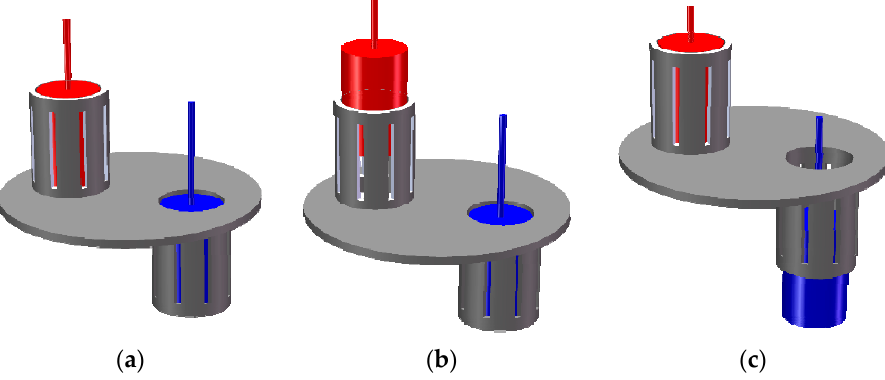
Figure 3. The response modes of the self-adaptive auxiliary control (SAC) system. ( a ) Standby mode, ( b ) Pressure release mode, ( c ) Pressure compensate mode.